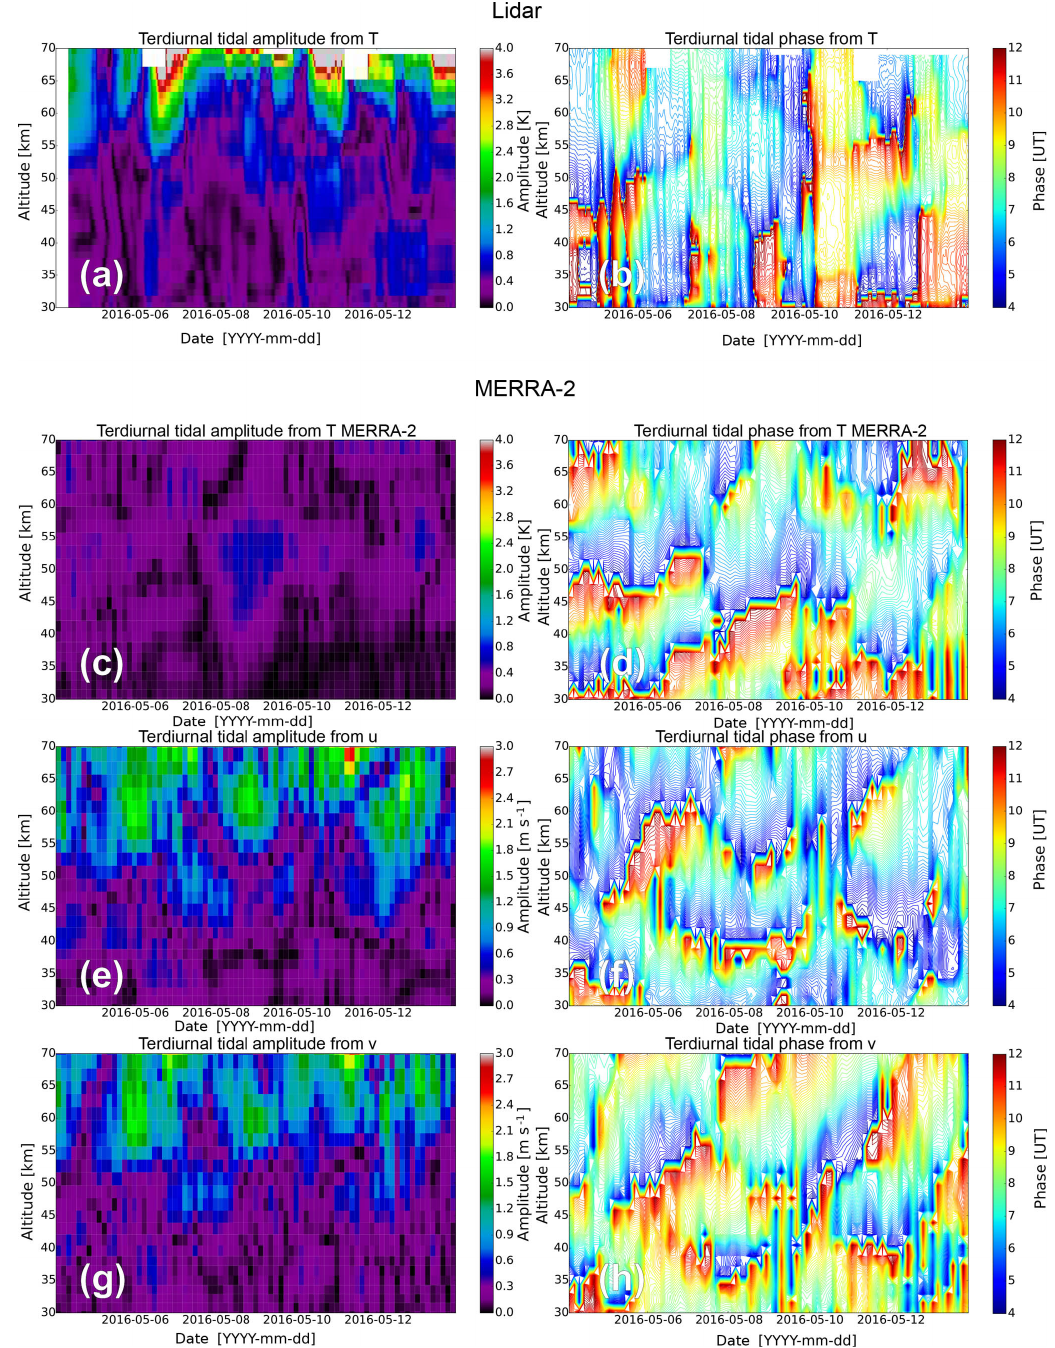
Figure 9. Same as Fig. 7 but for the terdiurnal tidal signature. Note the different color scale for the phases, compared to Figs. 7 and